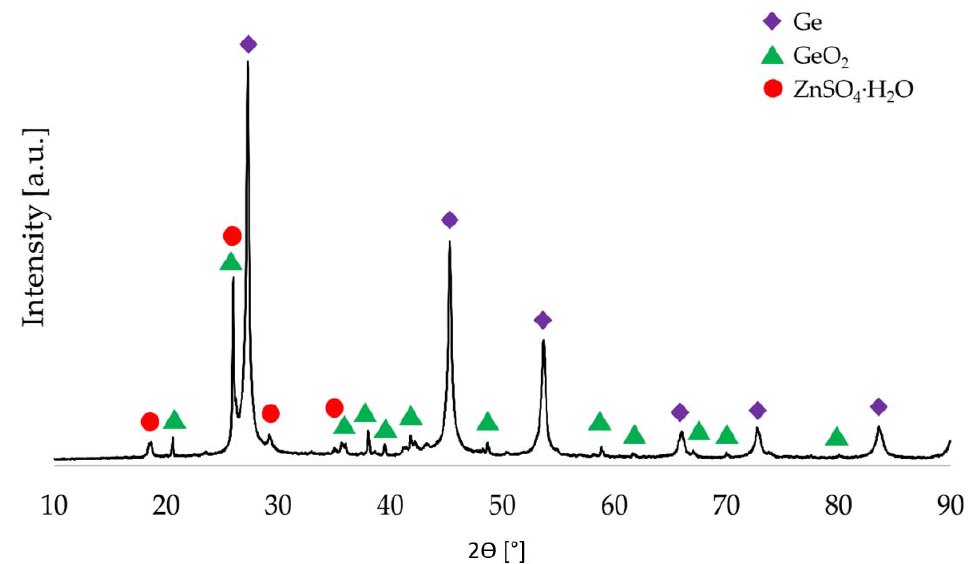
Figure 7. XRD pattern of precipitate obtained after cementation of detinned solution with zinc dust (75 ◦ C, 2 h, 100 g / dm 3 Zn dust); a.u.—arbitrary (75 °C, 2 h, 100 g/dm 3 Zn dust); a.u.—arbitrary units.